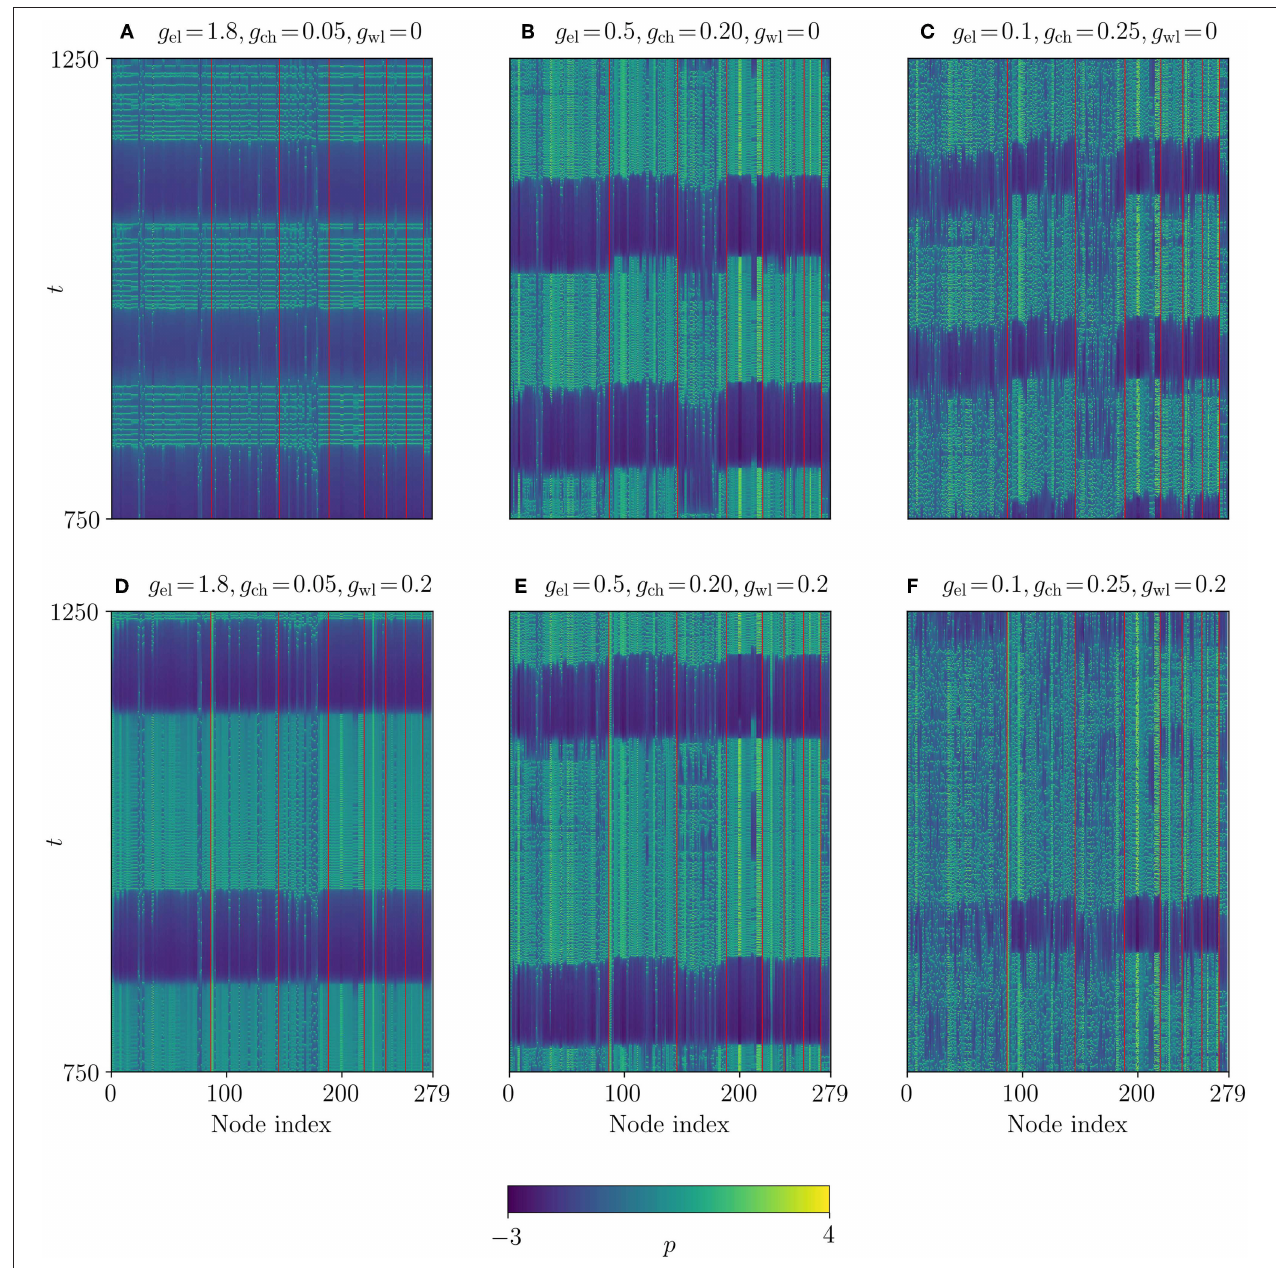
FIGURE 7 | Space-time plots of the Multilayer-Louvain network. The system parameters are the same as in Figure 3 , except for g wl . (A–C) Temporal evolution of the p -variable for different g el and g ch with g wl = 0. (D–F) Similar plots for g wl = 0.2. The values of all coupling strengths are summarized in Table 1 . Red lines separate different